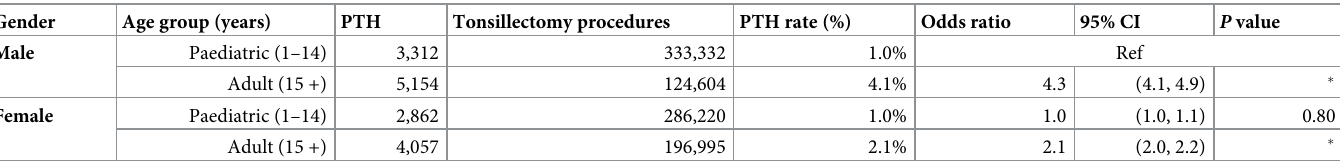
Table 3. Comparison of age-specific post-tonsillectomy haemorrhage rates between the adult and paediatric age groups between the male and female genders. Gender